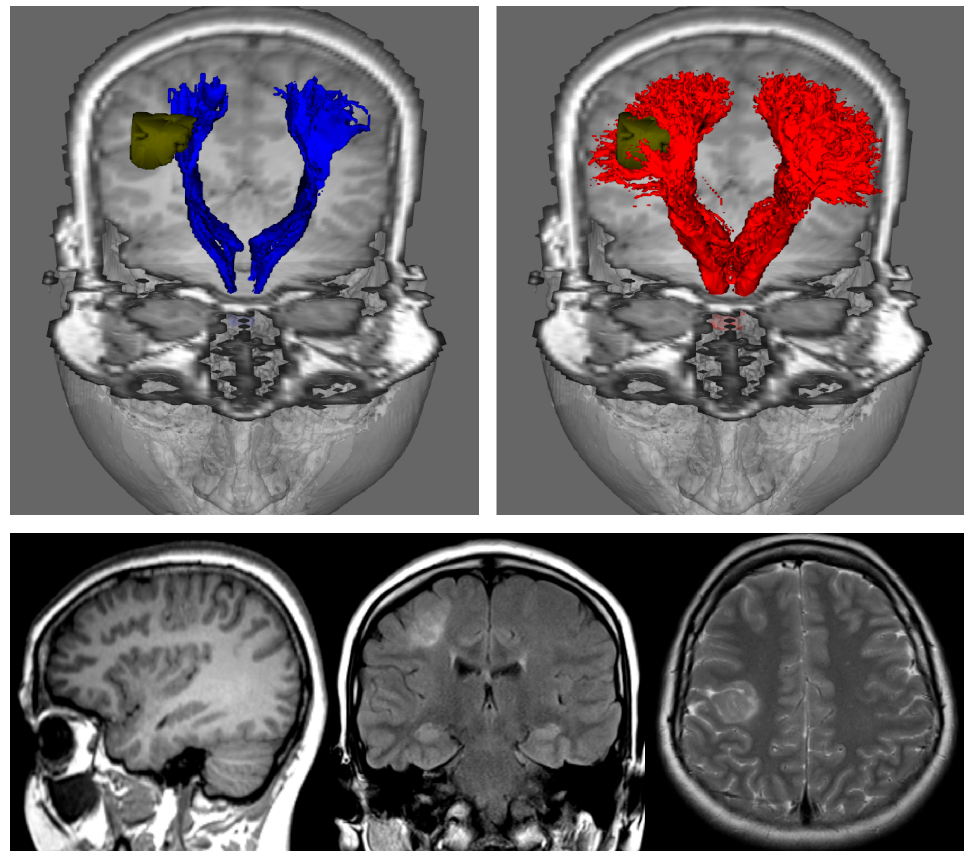
Figure 3. Fibre-tracking results on a 24-year-old woman with a right focal cortical dysplasia situated in the right posterior frontal lobe (see images in bottom row). These results were obtained using a seed region in the brainstem and target regions in the sensorimotor cortices. DTI-based tractography (blue) and CSD-based tractography (red) were derived from the same diffusion MRI data set); segmented pathology volumes (green) overlaid on T1-weighted image. DTI-based tractography suggests that only the medial aspect of the lesion impinges on the corticospinal tracts, whereas CSD-based tractography suggests that the lesion is enveloped by medial and lateral projections. DTI: Di ff usion Tensor Imaging; CSD: constrained spherical deconvolution. Note that while only DTI combined with deterministic tracking is shown in the top-left image, the results of combining DTI with probabilistic tracking are expected to be very similar (cf. left and middle images in Figure 2). Figure modified from a figure previously published in [30], with permission of American Association of Neurological Surgeons,